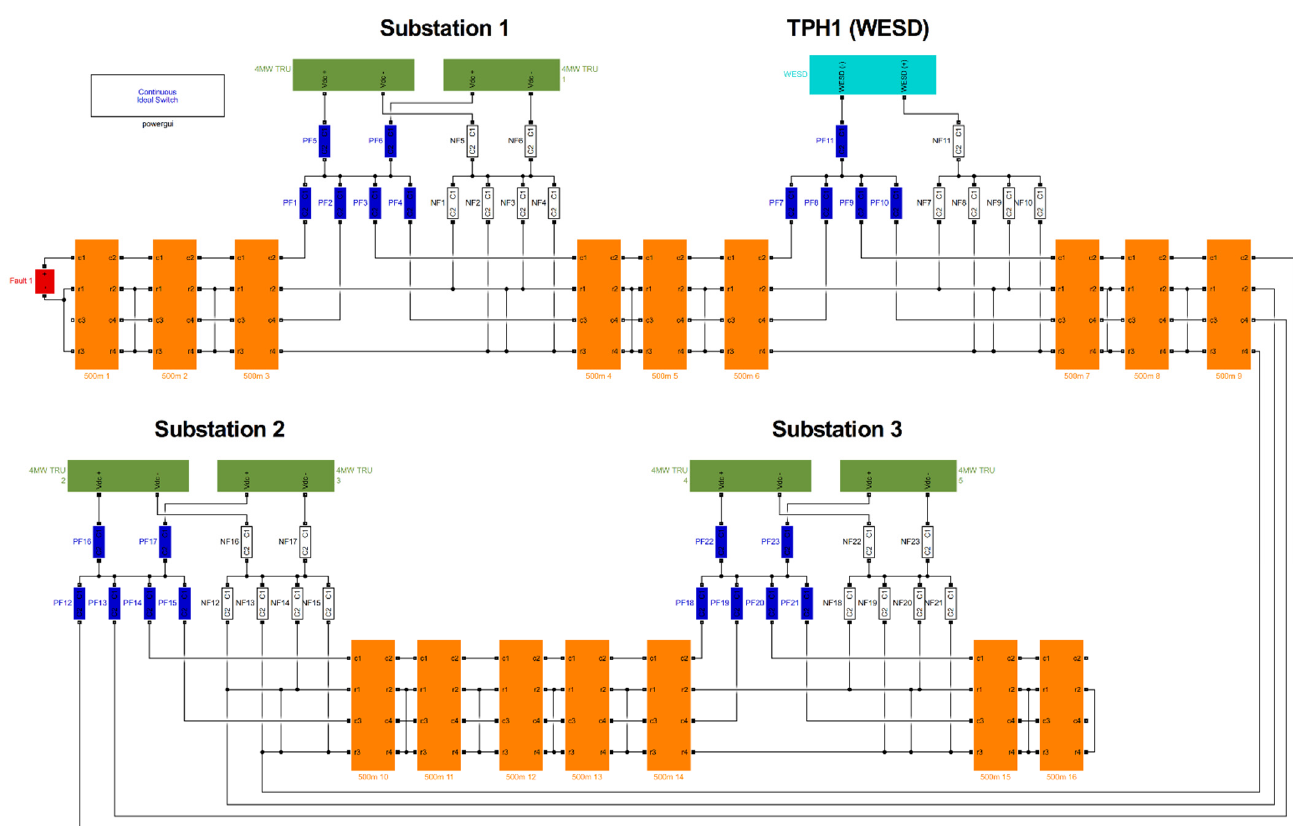
Figure 9. MATLAB/Simulink model of the 1500V DC traction power system.